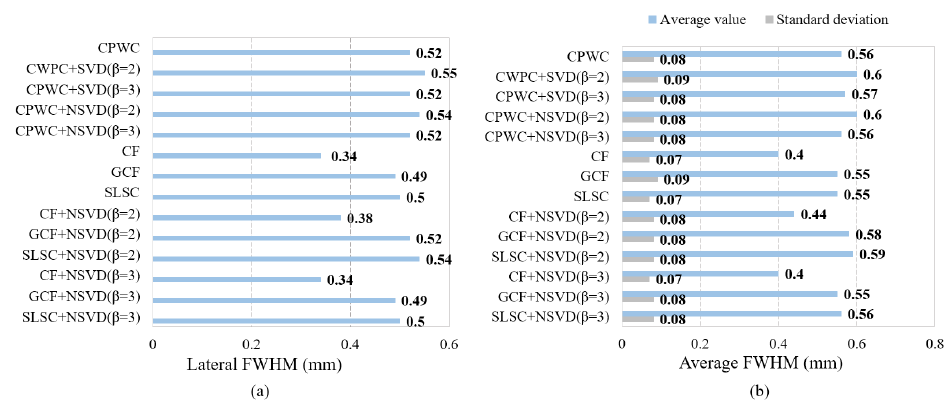
Figure 4. Lateral full width at half maximum (FWHM) in simulated images: ( a ) p 1 ( x , z ) = ( 0 mm,20 mm ) , ( b ) average values and standard deviation of all point